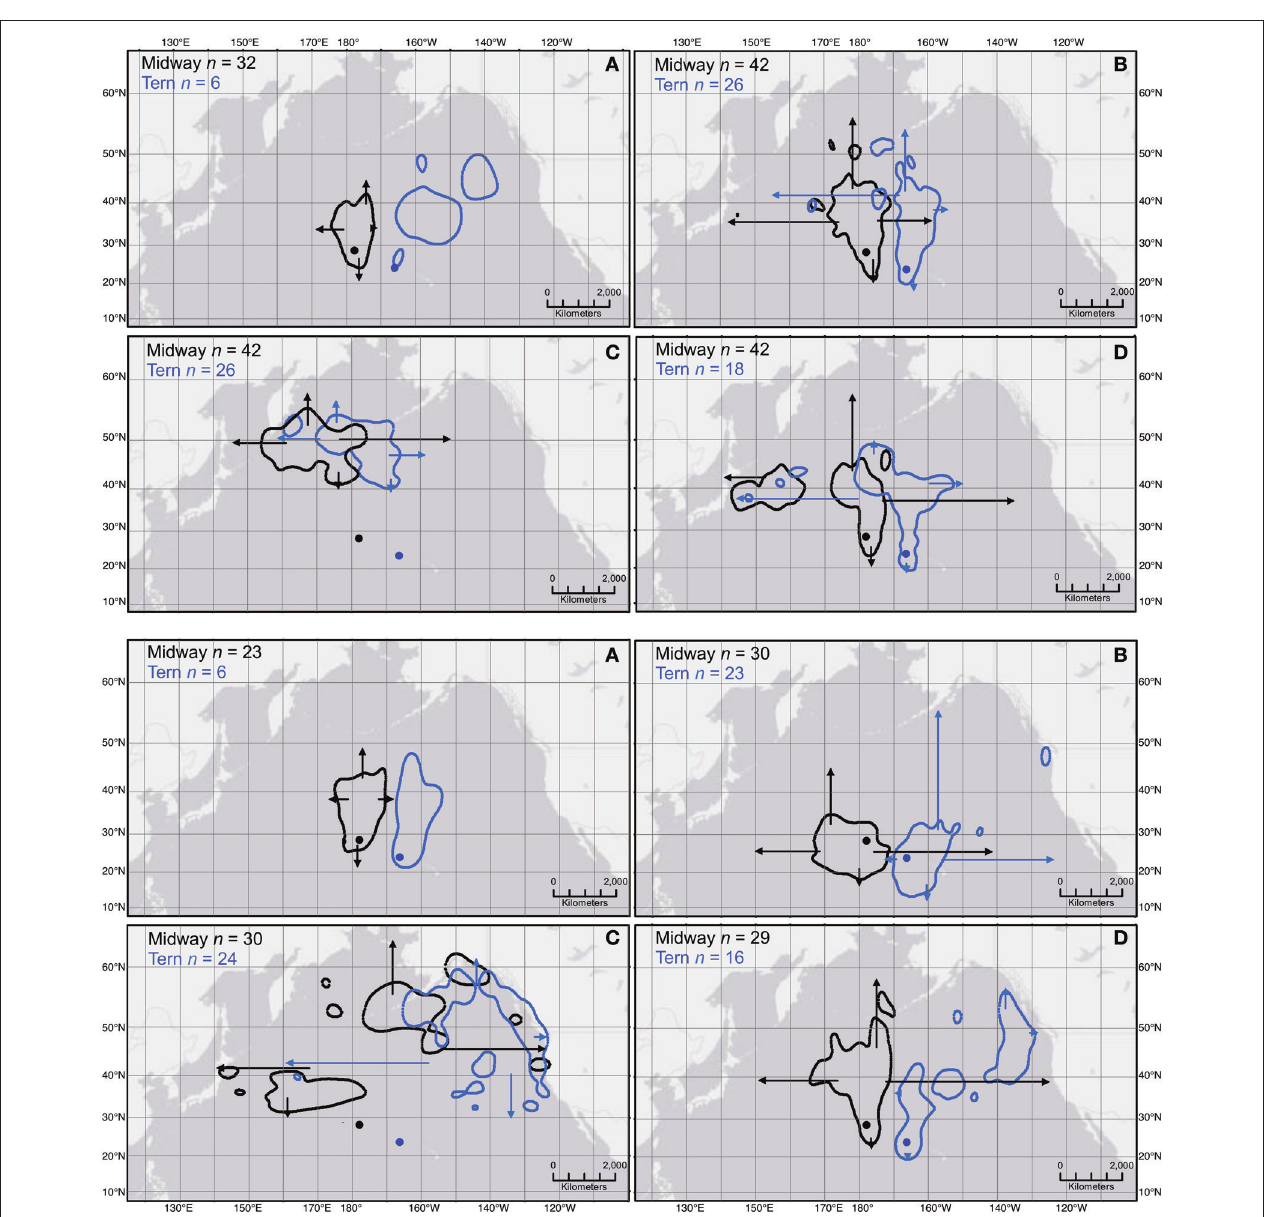
FIGURE 4 | Sampling effects on the location of 50% kernel contours from pooled KDE for two colonies of Laysan and black-footed albatross during four periods of the annual cycle. Polygons show 50% kernel contour results from pooled KDE including GLS location data from all individual Laysan albatross (top four panes) and black-footed albatross (bottom four panes) from Midway and Tern ( n shown in each pane). Arrows depict the outermost extents of 50% kernel contours (northern, eastern, southern, and western limits for each set of polygons) resulting from 100 KDE generated from the daily locations of 15 randomly selected individuals from the full dataset for each colony. The outermost perimeter of the 50% kernel contour from KDEs ranged between the beginning and end of each arrow in the four cardinal directions as shown. Each set of four panes represent the four periods of the annual cycle: (A) ECR, (B) LCR, (C) OW, and (D) PBE (see Figure 1 ). Colonies are indicated by solid circles in their respective colors (projection: World Azimuthal Equidistant, datum: